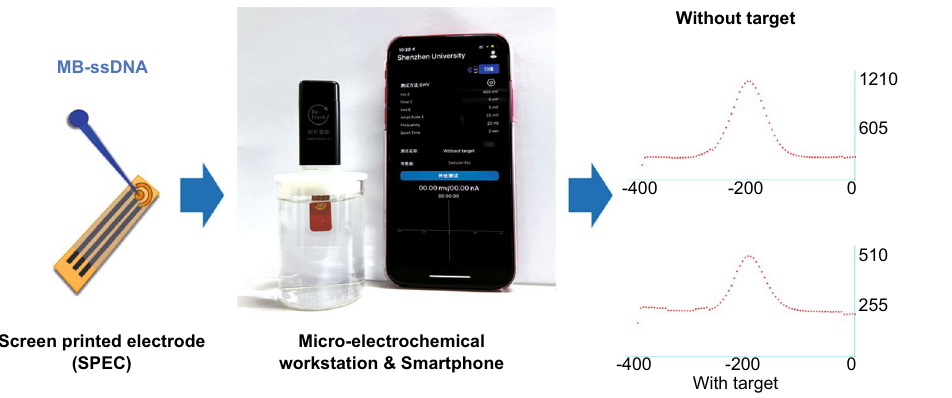
Fig. 5 Schematic illustration, primary assay photograph and experimental results of the E‑CRISPR application in POCT for SARS‑CoV‑2 Delta variant